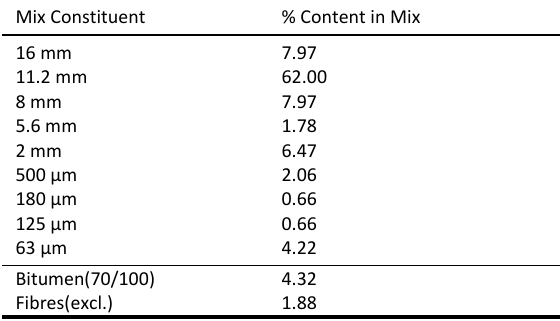
Table 1 . Mix Composition of Porous Asphalt Concrete Mix